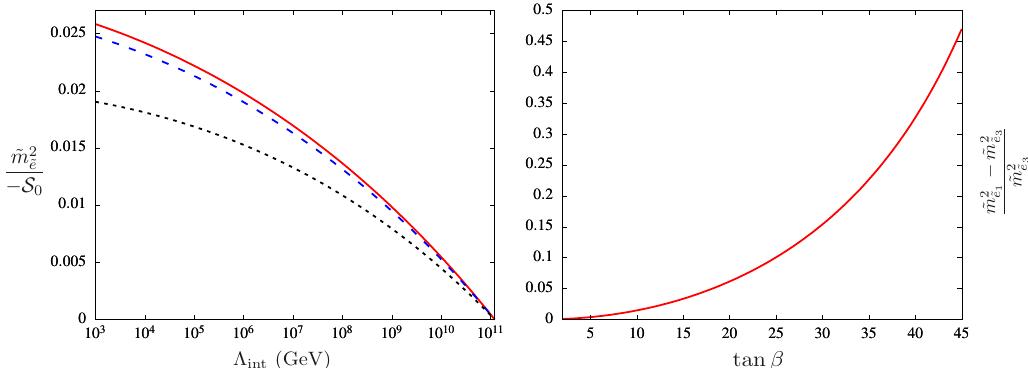
Figure 7 . In the left panel we show the running of the right handed slepton mass square scaled by as a function of the intermediate scale for di(cid:11)erent tan (cid:12) values of 2.5 (red-solid), 20 (blue- S 0 dashed) and 40 (black-dotted). In the left panel we present the mass splitting between the (cid:12)rst and third generation of right handed sleptons as a function of tan (cid:12) . The tan (cid:12) dependence manifests itself in the